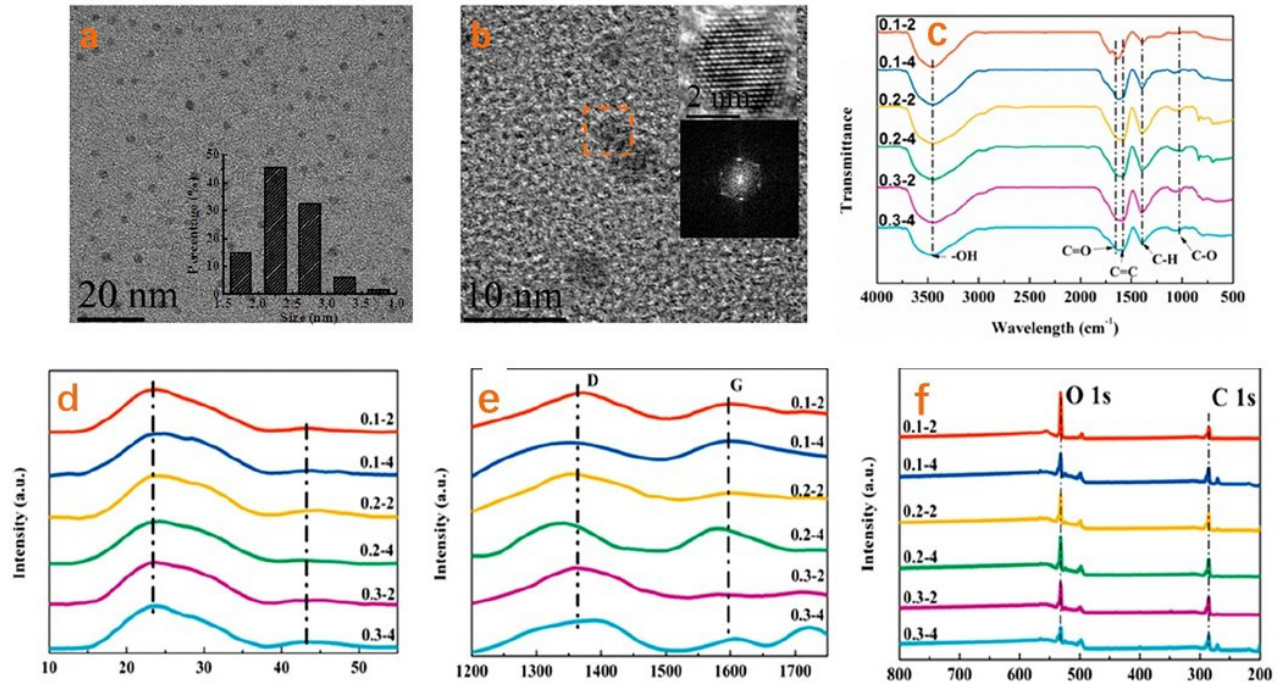
Figure 2. TEM ( a ), HR − TEM ( b ), FT − IR spectra of CDs ( c ), XRD pattern ( d ), Raman spectrum ( e ), XPS survey ( f ) of the CDs (sample 0.2–2), (reproduced with permission from ref. [92]).